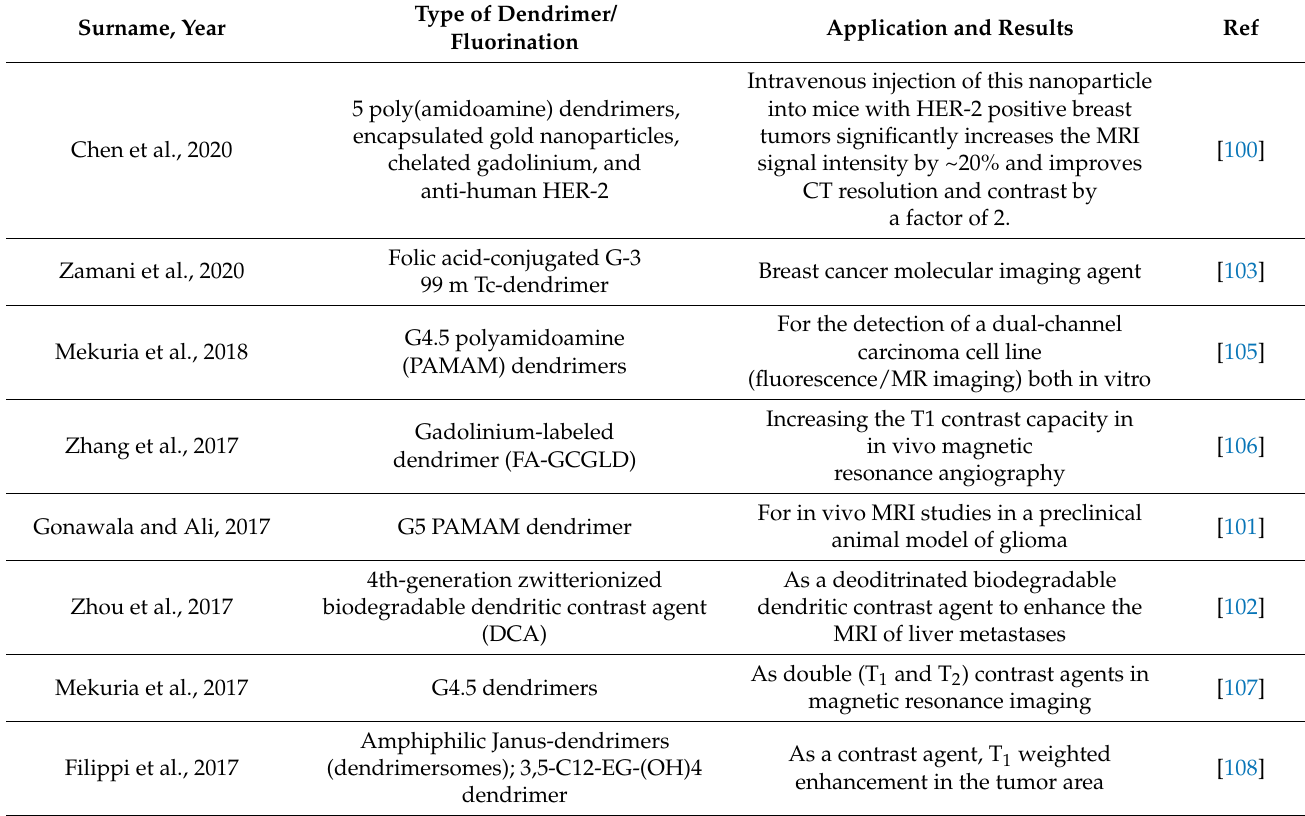
Table 3. Use of dendrimers as contrast agents in in vivo